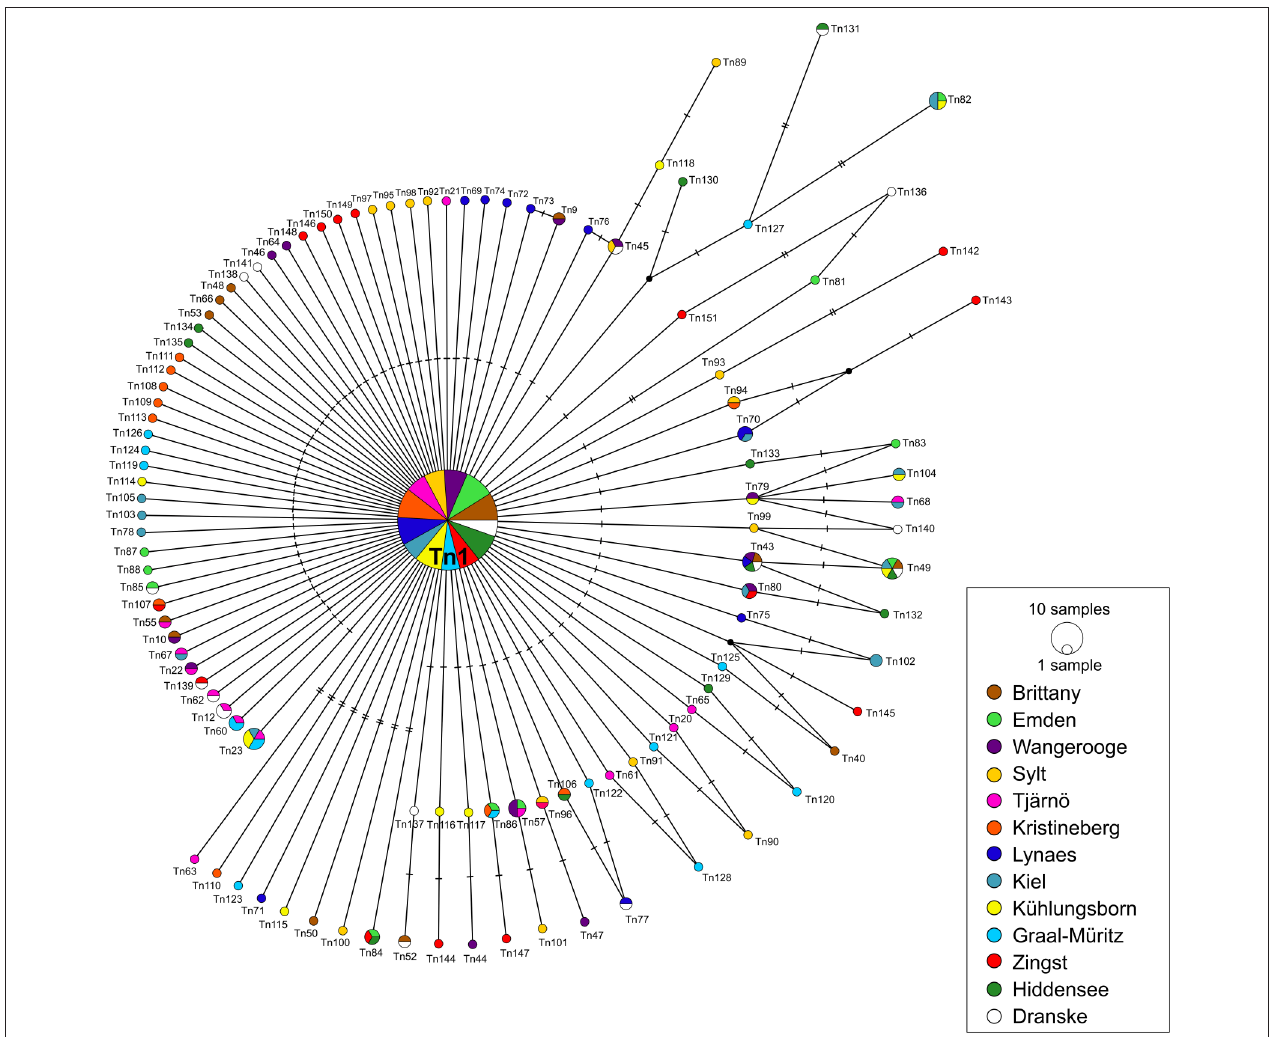
FIGURE 2 | COI haplotype network of DS 1 ( n = 299) based on median-joining analysis. Each circle represents a different haplotype. The size is proportional to the number of individuals sharing the same haplotype. Small black dots are median vectors indicating not sampled or missing haplotypes. Short black bars correspond to the number of mutation steps between the haplotypes (one to seven). Sampling sites listed from west to east.